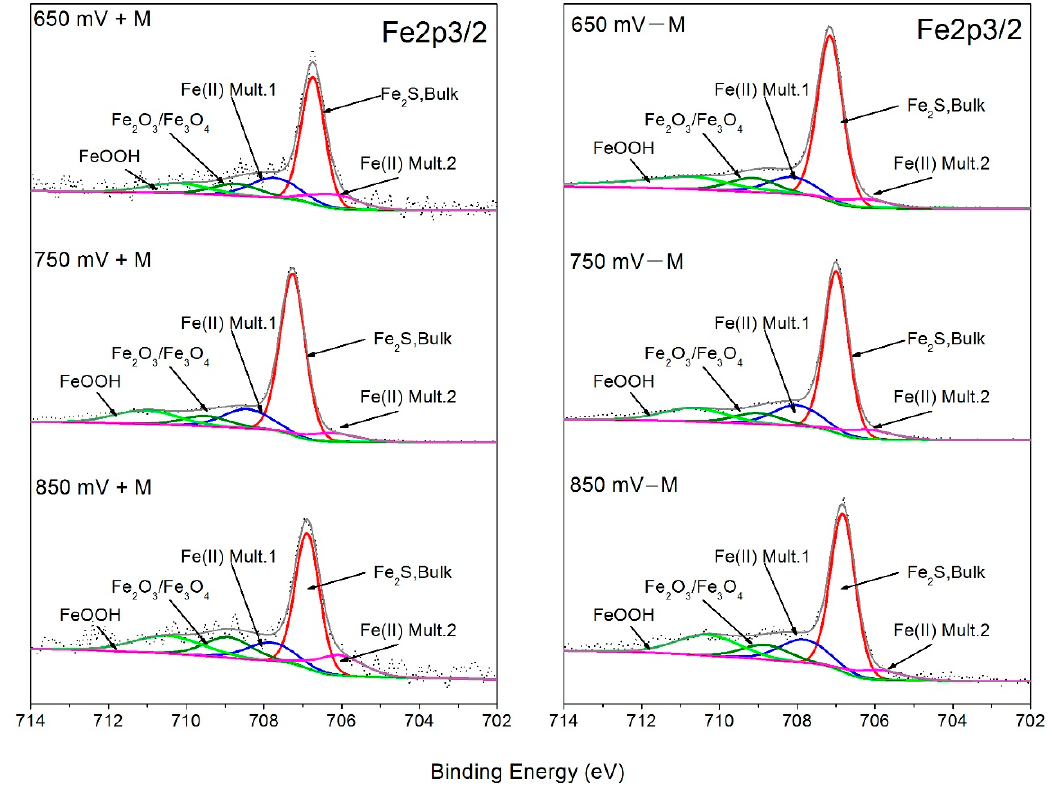
Figure 6. Fe 2p3/2 XPS spectra of pyrite surfaces under different conditions. Figure 6. Fe 2p3 / 2 XPS spectra of pyrite surfaces under di ff erent